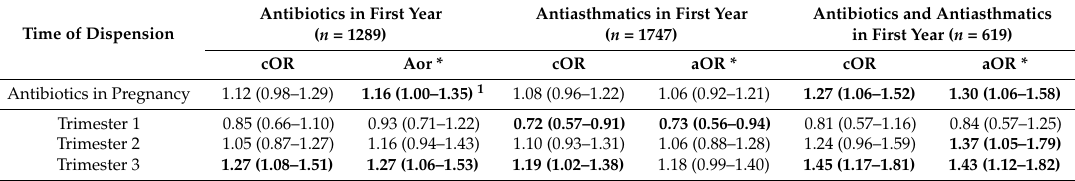
Figure 2. The number of women prescribed antibiotics in pregnancy and the number of children prescribed antibiotics/antiasthmatics during the first year of life [15]. Table 2. Estimated crude odds ratios (cOR) and adjusted odds ratios (aOR) with 95% confidence intervals between antibiotic exposure in pregnancy and dispensed antibiotics and/or dispensed antiasthmatics during the first year of life. (Statistically significant ORs in bold, p < 0.05)